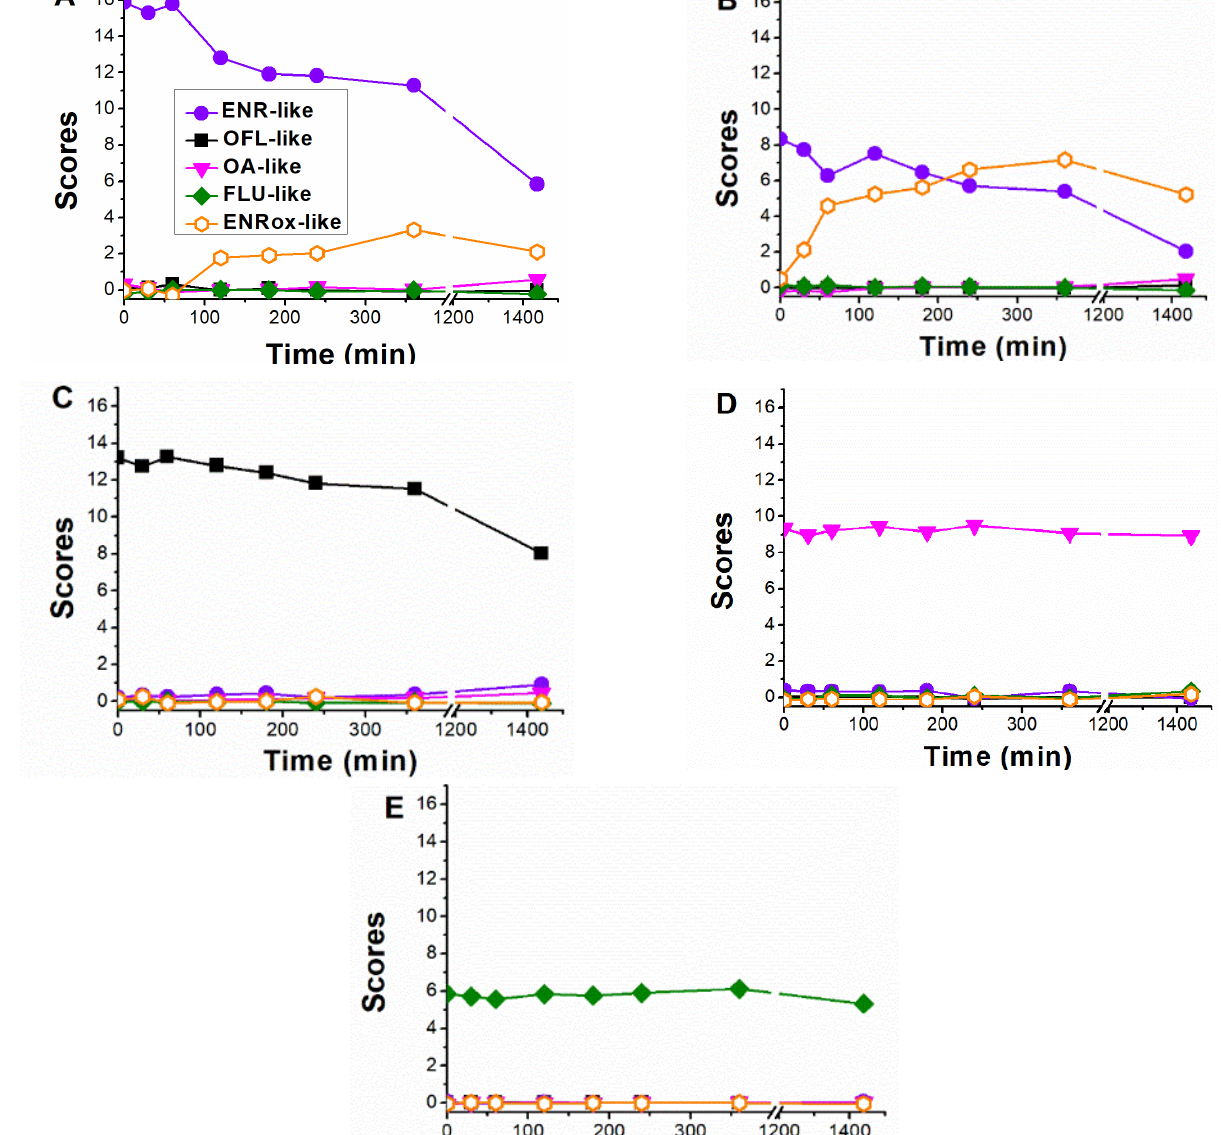
Figure 4. PARAFAC components evolution obtained for the different photolysis experiments: ( A ) enrofloxacin (ENR), ( B ) ciprofloxacin (CIP), ( C ) ofloxacin (OFL), ( D ) oxolinic acid (OA), and ( E ) flumequine (FLU). The initial score values for ENR-like, OFL-like, OA-like, and FLU-like reflect the fluorescence intensity differences from the studied (F)Qs.